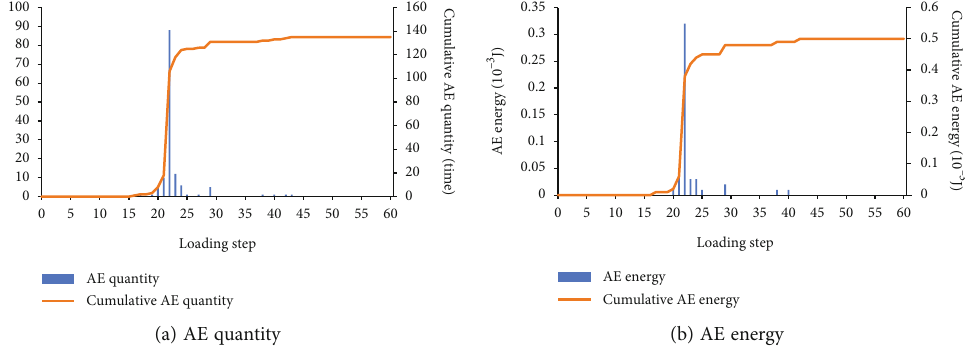
Figure 10: AE change curve when the distance a is 50mm.